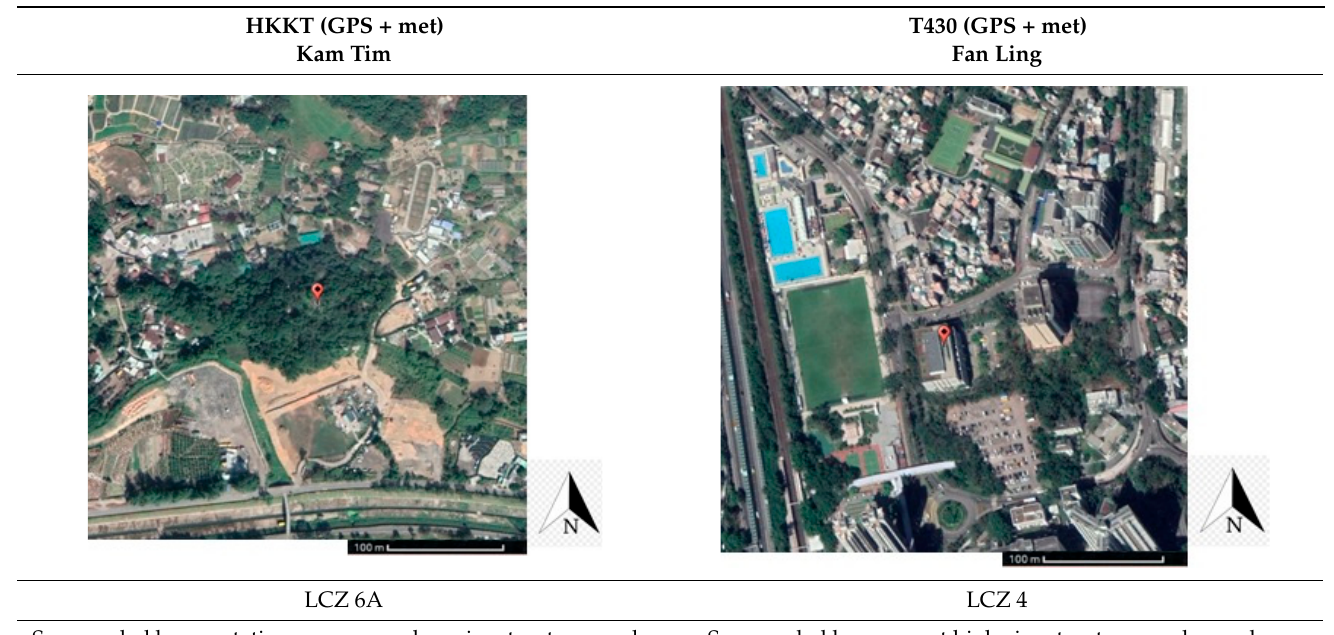
Table 2. Urban stations in Hong Kong.